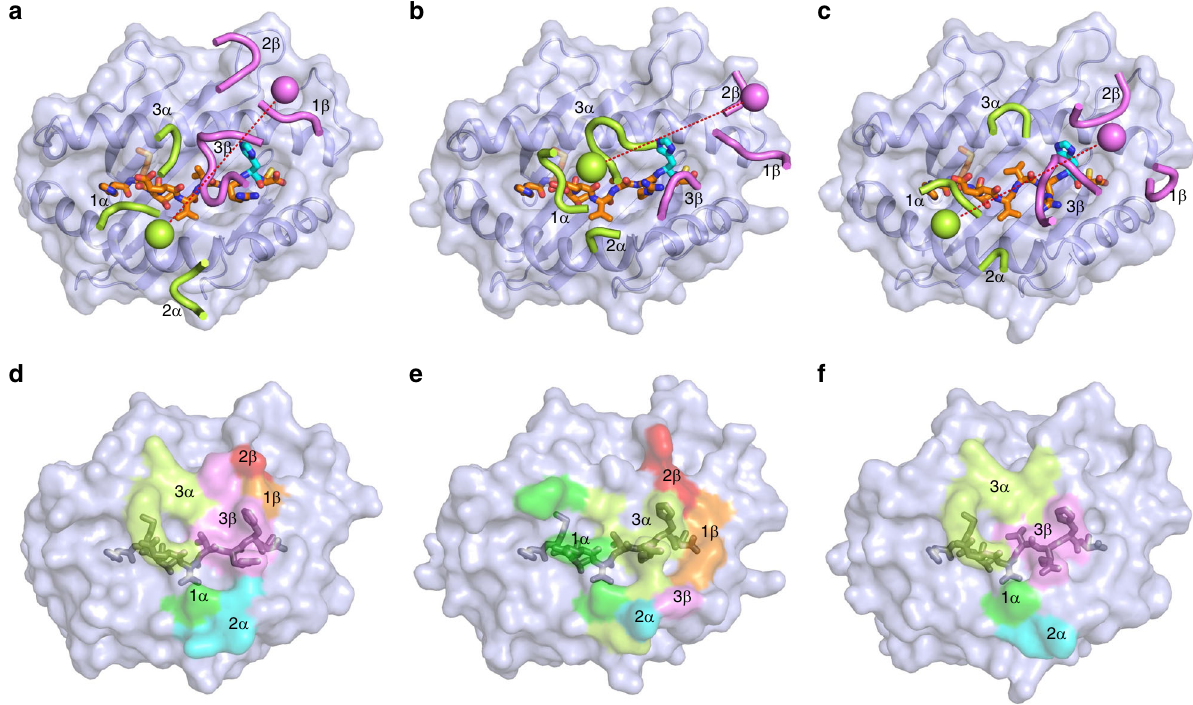
Fig. 4 Comparison of TCR footprints on p53R175H – HLA-A2. a Positions of CDR loops of TCR 12-6 on p53R175H – HLA-A2 (top view). CDRs of 12-6 are shown as numbered green (CDR1 α , CDR2 α , and CDR3 α ) or violet (CDR1 β , CDR2 β , and CDR3 β ) loops. HLA-A2 is depicted as a light blue surface. The p53R175H peptide is drawn in orange in stick representation with the mutated P8 His residue in cyan. The green and violet spheres mark the positions of the conserved intrachain disul fi de of the V α and V β domains, respectively. The red dashed line indicates the crossing angle of TCR to pMHC. b Positions of CDR loops of TCR 38-10 on p53R175H – HLA-A2 (top view). c Positions of CDR loops of TCR 1a2 on p53R175H – HLA-A2 (top view). d Footprint of TCR 12-6 on p53R175H – HLA-A2. The top of the MHC molecule is depicted as a light blue surface. The areas contacted by individual CDR loops are color-coded: CDR1 α , dark green; CDR2 α , cyan; CDR3 α , light green; CDR1 β , orange; CDR2 β , red; CDR3 β , pink. e Footprint of TCR 38-10 on p53R175H – HLA-A2. f Footprint of TCR 1a2 on p53R175H – peptide C-terminus (Supplementary Table 4) as a result of positioning one or both of their CDR3 loops directly over P8 His (Fig. 6a – c). In the unbound p53R175H – HLA-A2 structure (Fig. 2a), the P8 His imidazole ring has one face against the side chain of Val76H of the HLA-A2 α 1 helix, leaving its other face and most of its edge available for TCR binding. Each TCR provides close contacts that tightly sandwich the imidazole between Val76H and a speci fi c CDR3 side chain: CDR3 β Gln99 in 12-6, CDR3 α Tyr103 in 38-10, and CDR3 β Gln97 in 1a2 (Fig. 6c). In addition, the phenyl ring of CDR3 α Tyr103 forms π – π stacking interactions with the imidazole ring of P8 His. Further selectivity for the mutant p53 peptide arises from hydrogen bonds with the P8 His side chain: 12-6 Glu95 β O ε 2 – N δ 1 P8 His, 12-6 Trp98 β Ν ε 1 – N ε 2 P8 His, 38-10 Tyr31 β OH – N δ 1 P8 His, and 1a2 Ser98 α O γ – N ε 2 P8 His (Supplementary Table 6).